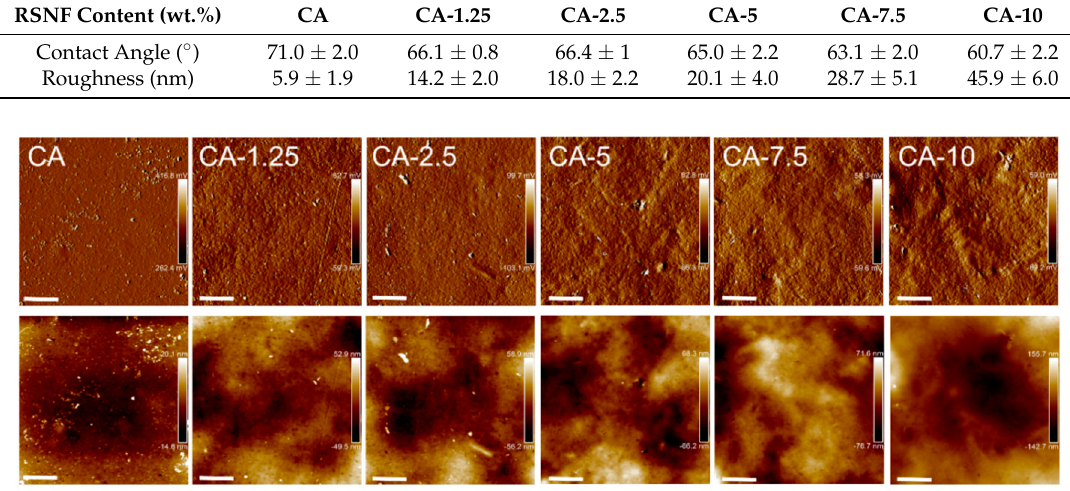
Figure 6. AFM amplitude (above) for CA with different RSNF content and their corresponding height images (below) from where roughness was measured. Scale bar is 3 µm.